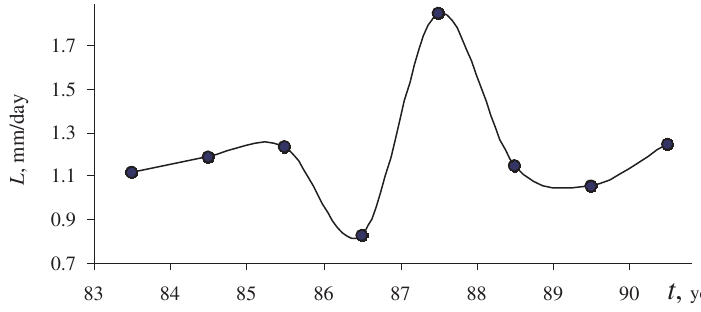
Fig. 9. Averaged annual level of atmospheric precipitation in Bishkek as a function of the